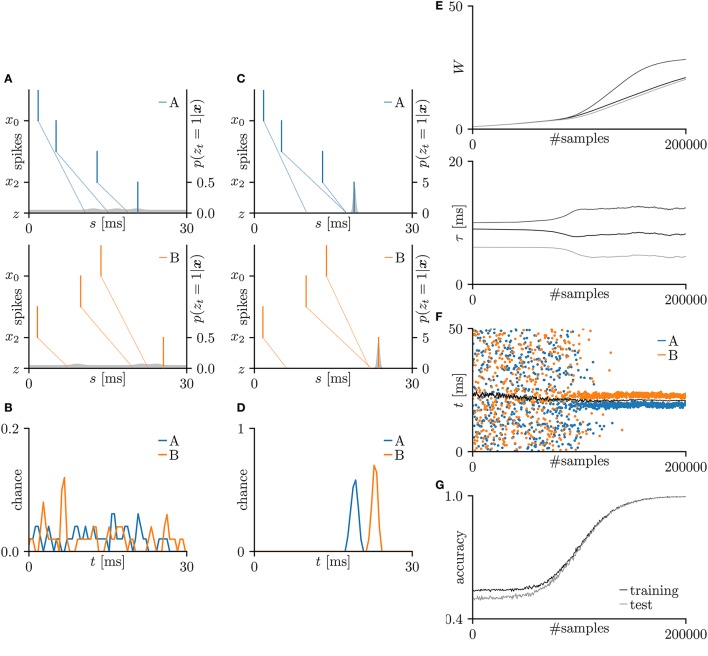
Results of SNN based on the Multinoulli-Bernoulli mixture model, evaluated on toy spike patterns. (A) Representative spatio-temporal spike patterns A (top panel) and B (bottom panel), and the post-synaptic spikes zt = 1 before the learning procedure. Vertical lines represent pre-synaptic spikes xis = 1 and post-synaptic spikes zt = 1 (the left vertical axes). Dotted lines denote transmission of the pre-synaptic spikes xis = 1 to the post-synaptic neuron z with conduction delays τi. Gray shaded areas denote the probability of eliciting a post-synaptic spikes zt = 1 per 1 ms (the right vertical axes). (B) Test distributions of the post-synaptic spike timings zt = 1 before learning. (C) Post-synaptic spike timings zt = 1 after learning, given the spatio-temporal spike patterns x in (A). (D) Test distributions of the post-synaptic spike timing zt = 1 after learning. (E) Trajectories of the synaptic weights Wi and conduction delays τi during the learning procedure. The darkest lines denote the values of the parameters W0 and τ0, and the lighter lines denote Wi and τi for i = 1, 2, … . (F) Random samples of the post-synaptic spike timings zt = 1. The black solid line marks the decision boundary between spike patterns A and B. (G) Classification accuracy in the training and test datasets, each averaged over 100 trials.